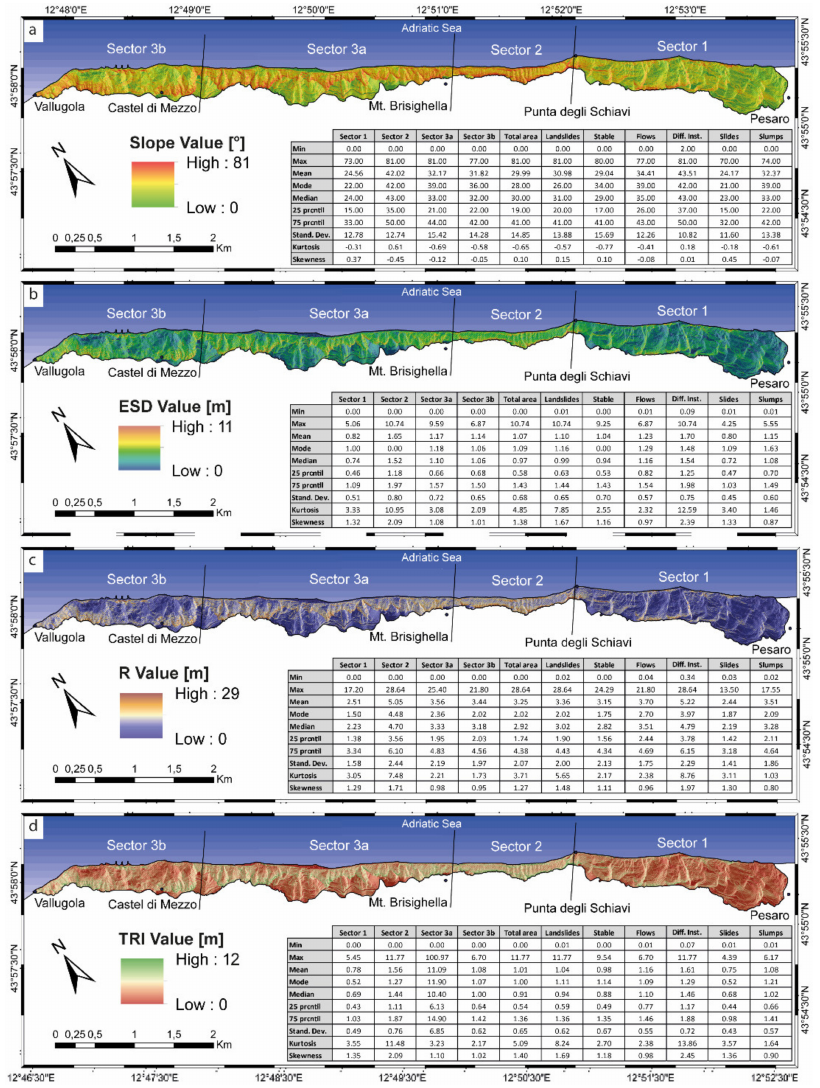
Figure 5. Spatial distribution of the selected morphometric variables along the Mt. San Bartolo coastal slope: slope ( a ), ESD ( b ), R ( c ), and TRI ( d ). For each variable, a descriptive statistic of the computed values is also provided (table in the right corner of each